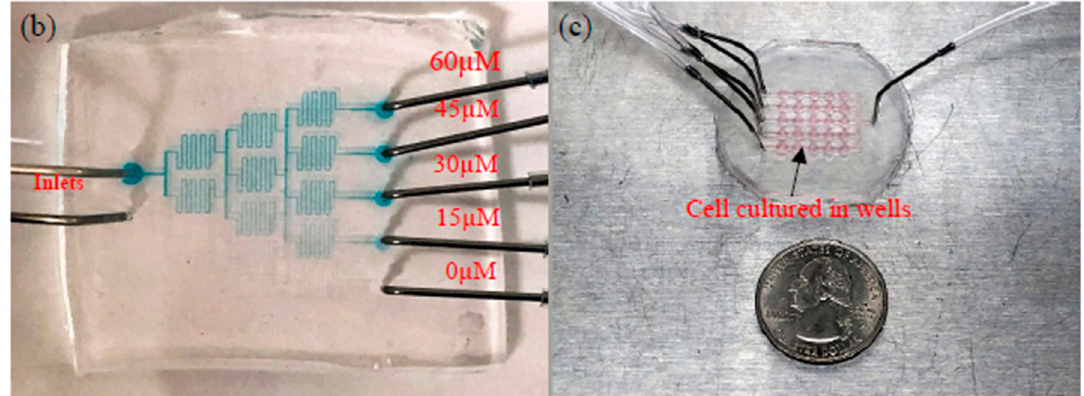
Figure 3. Current microfluidic device setup for GPR120 receptor detection; ( a ) two parts connected by tubing; ( b ) concentration gradient generator at a flow rate of 50 µL/min; ( c ) human embryonic kidney cell lines transfected with an inducible GPR120 gene (HEK293-GPR120) cell cultured in a well array.